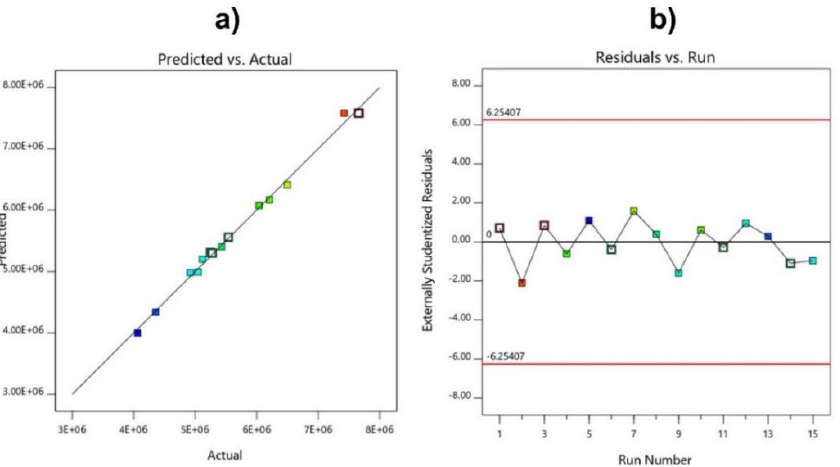
Figure 8. Predicted and actual value plots ( a ), and residuals versus run models ( b ), for molecular weight.